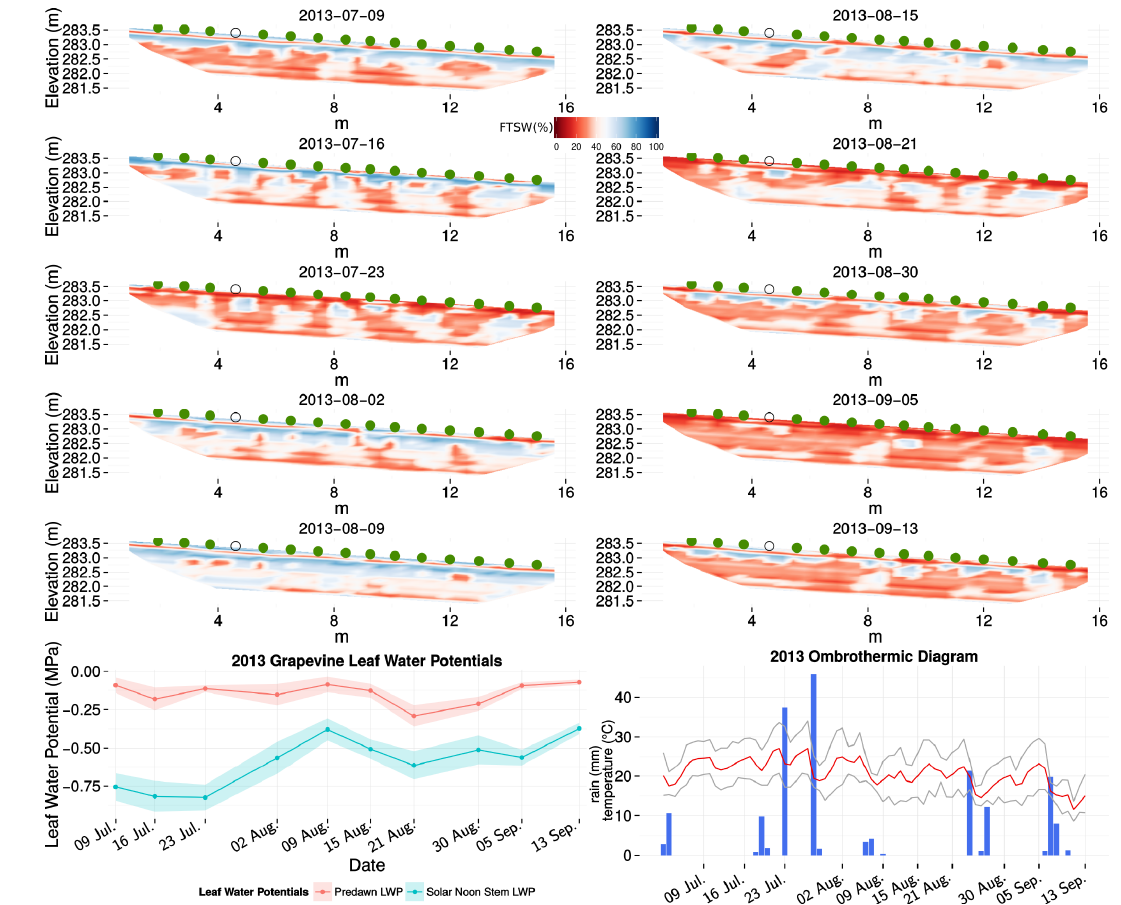
Figure 2. Weekly estimation of the fraction of transpirable soil water (FTSW) in a vineyard soil spatialised in 2-D by electrical resistivity tomography. Green-filled dots represent fully developed plants and empty dots represent very young plants (1 year). The bottom-left panel shows the grapevine water stress variation as measured by leaf water potentials, and the bottom-right panel the ombrothermic diagram of 2013 vintages, temperatures and